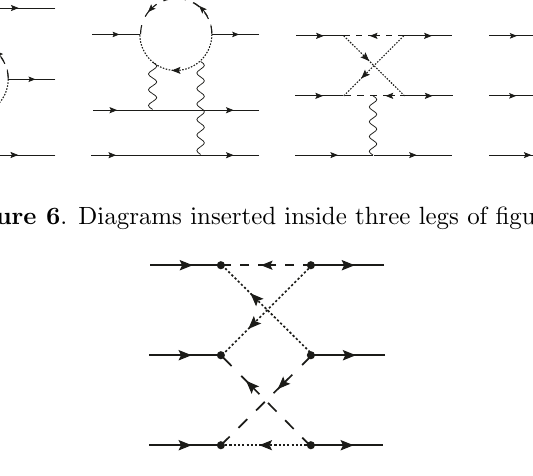
Figure 7 . Diagram to be inserted inside (cid:12)gure 1. Its space-time loop integral is denoted by W 6 ( x ) and does not depend on n . When we insert this diagram inside G n it yields a prefactor denoted by K n